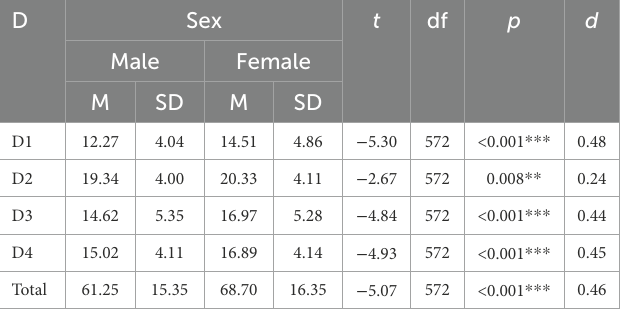
TABLE 3 T-test based on the sex